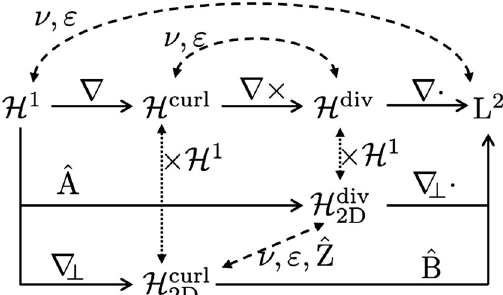
FIG. 2. De Rham diagram for the used operators and ˆ A ∶ H 1 ð Ω Þ → H div 2 function spaces. The operators ð Ω Þ and D ˆ B ∶ H curl Ω Þ → L 2 ð Ω Þ are the 2D vectorial and scalar curl 2 D ð ˆ Z operators, respectively, and ν ; ε ; are invertible Hodge operators. The 2D spaces are supplemented by H 1 to obtain their 3D z -periodic